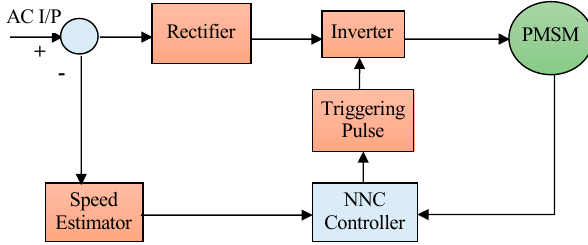
Figure 7. Structure of ANN layers.